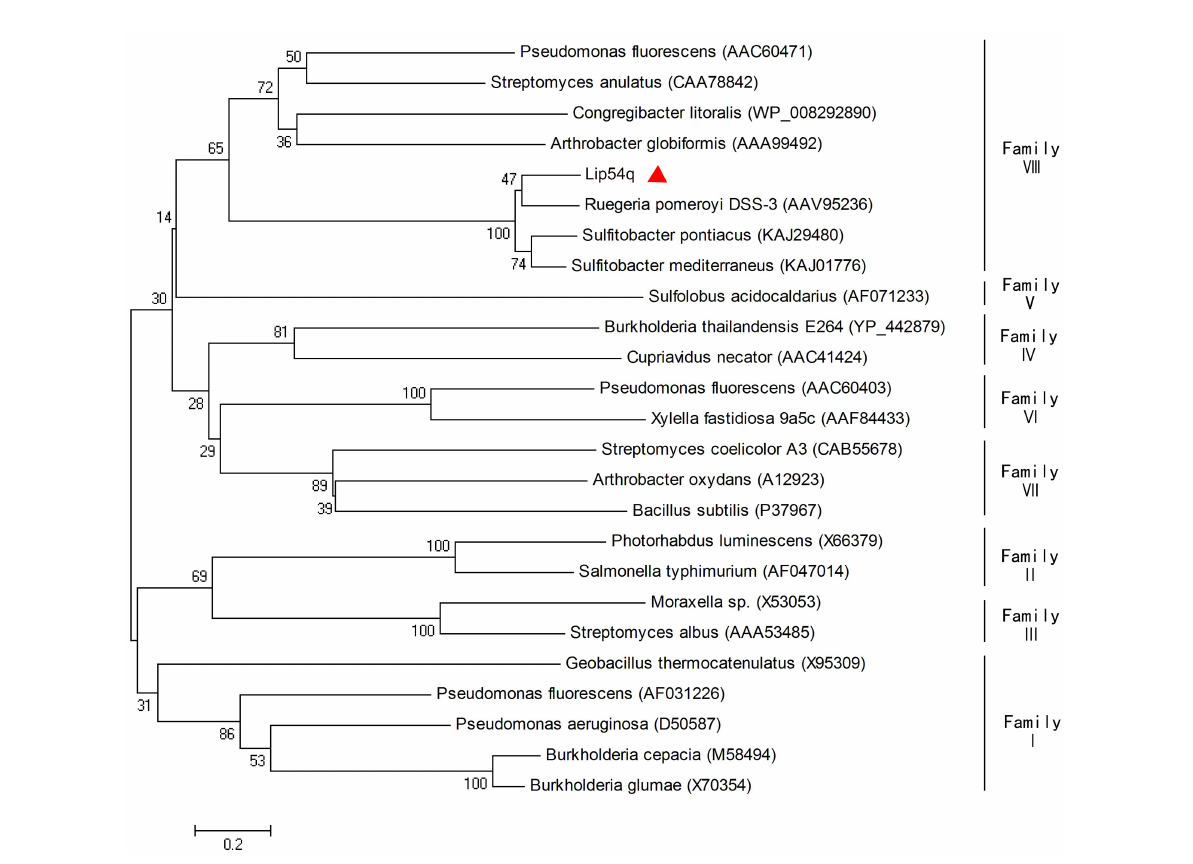
FIGURE 2 Phylogenetic analysis of Lip54q and closely related lipolytic enzymes. The phylogenetic tree was constructed using MEGA 7.0 software by the neighbor-joining method. All protein sequences were retrieved from NCBI GenBank. The units at the bottom of the tree indicate the number of substitution events. Numbers near a branch show the percentage of reliability in the bootstrap test of that branch.